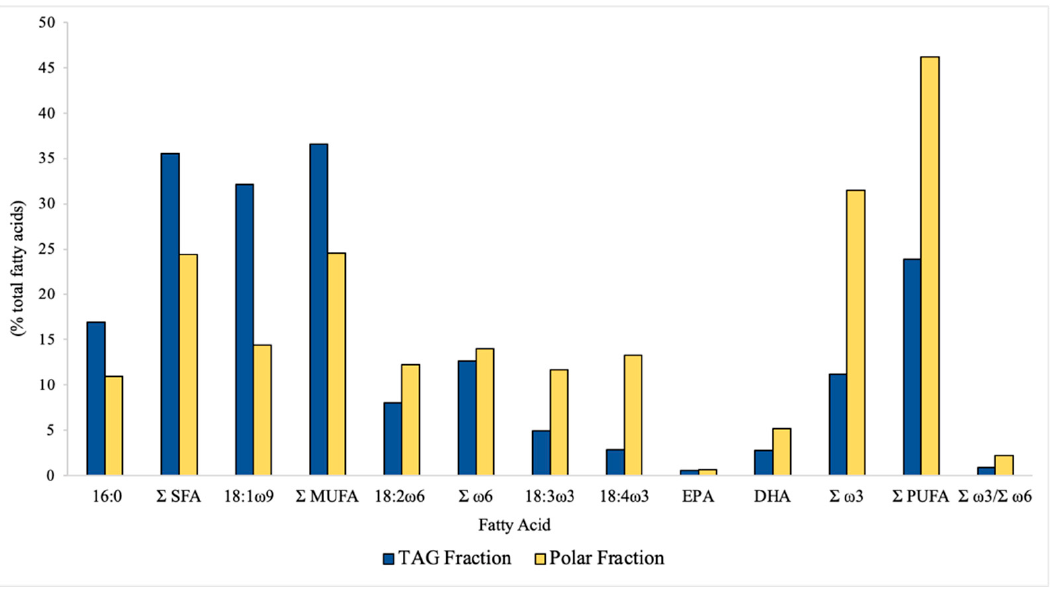
Figure 2. Fatty acid profile (in % of total fatty acids) of I. galbana TAG (triacylglycerol) and polar fractions.